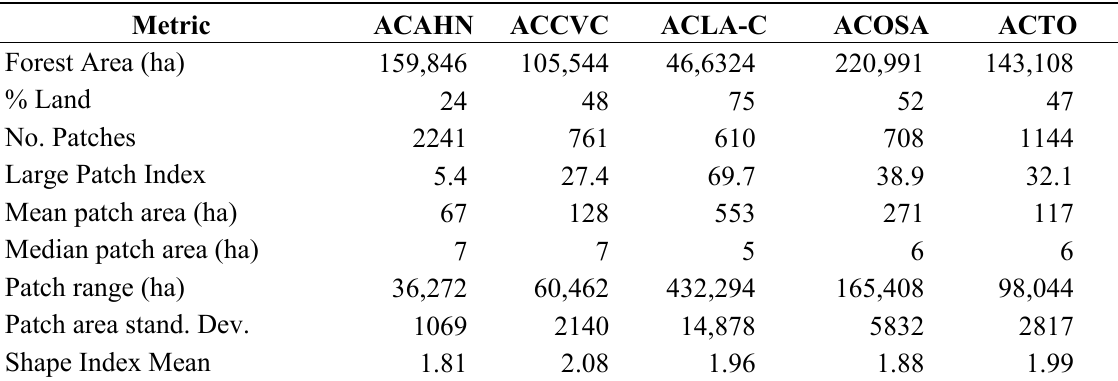
Table 3. Fragmentation statistics for five Conservation Areas in Costa Rica based on the Forest Cover Assessment